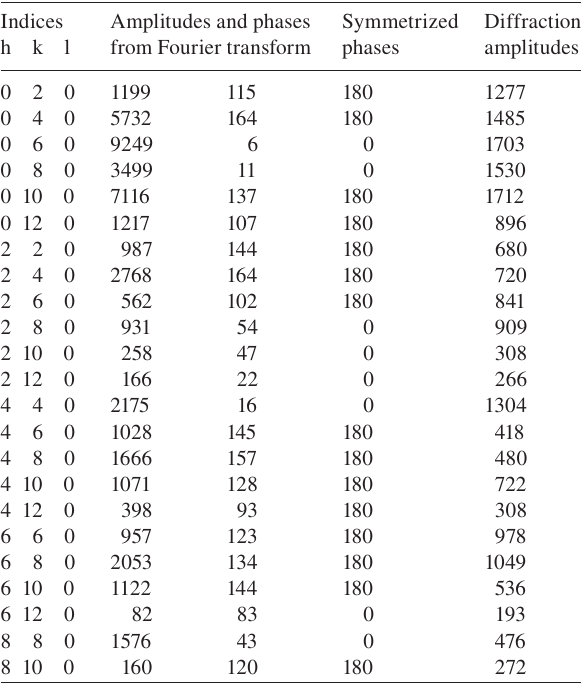
Table 5 Amplitudes and symmetrized phases of YB transform derived by crystallographic image processing of HREM images and amplitudes obtained from electron diffraction